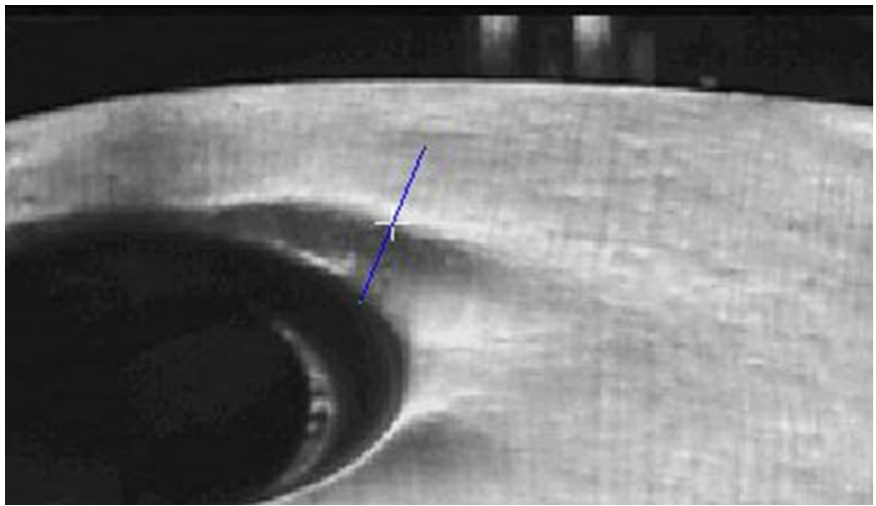
Figure 5. Selection of the start point of the